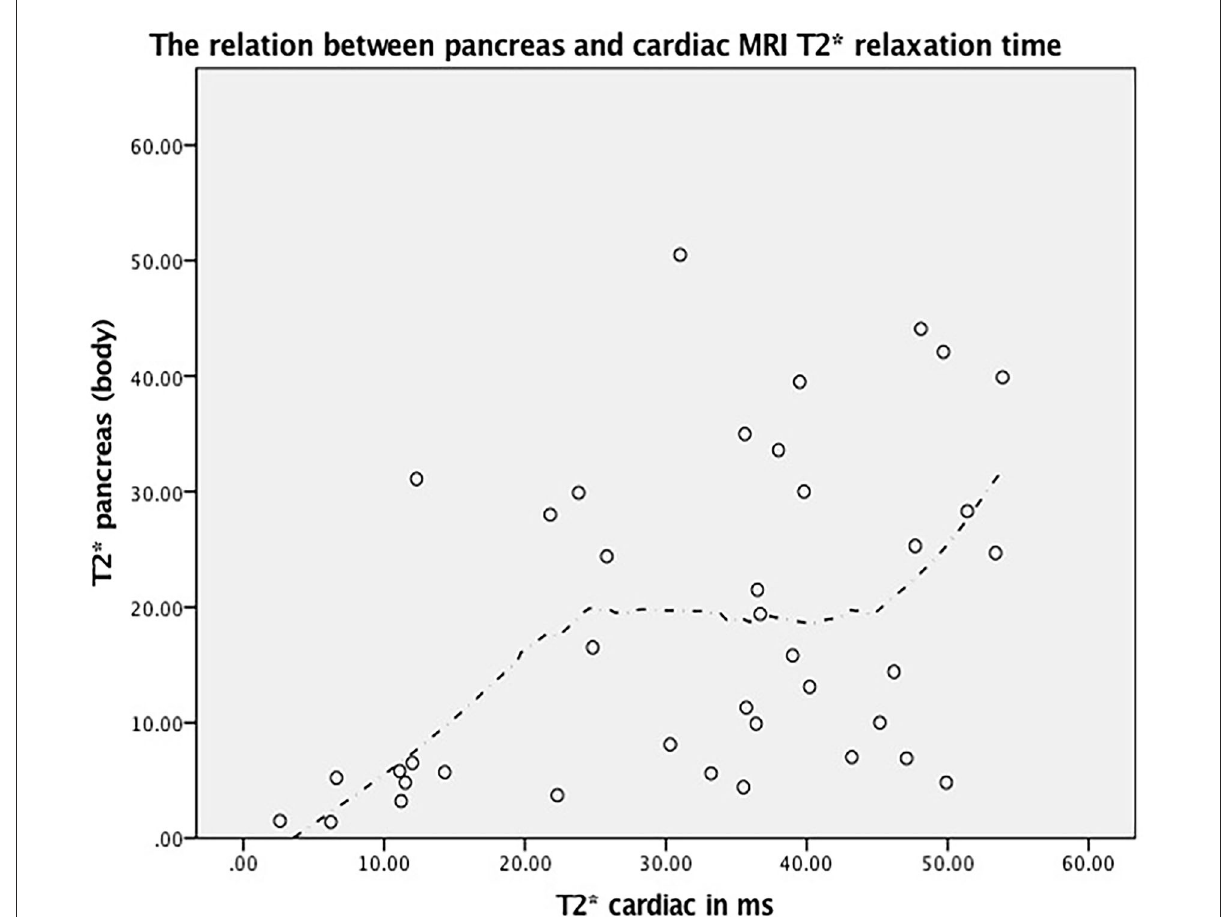
FIGURE2 The relation between pancreas and cardiac MRI T2* relaxation time (r = 0.504, P < 0.001) and its corresponding fitted line based on Loess